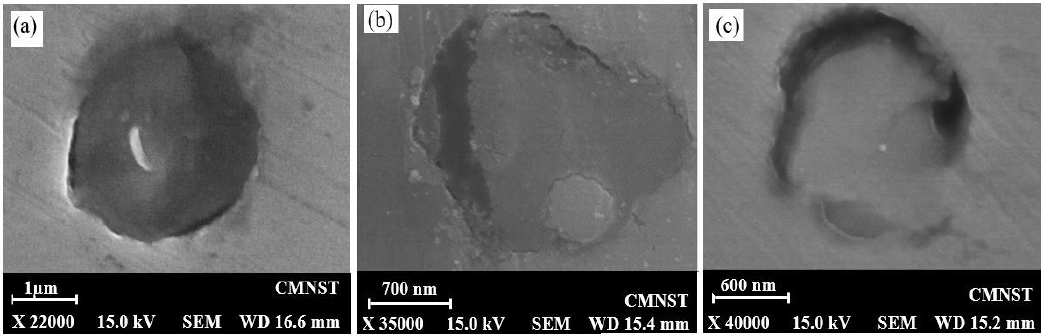
Figure 3. Inclusions morphology: ( a ) CeO 2 inclusion, ( b ) Ce 2 O 3 inclusion, ( c ) Ce 2 O 2 S inclusion.